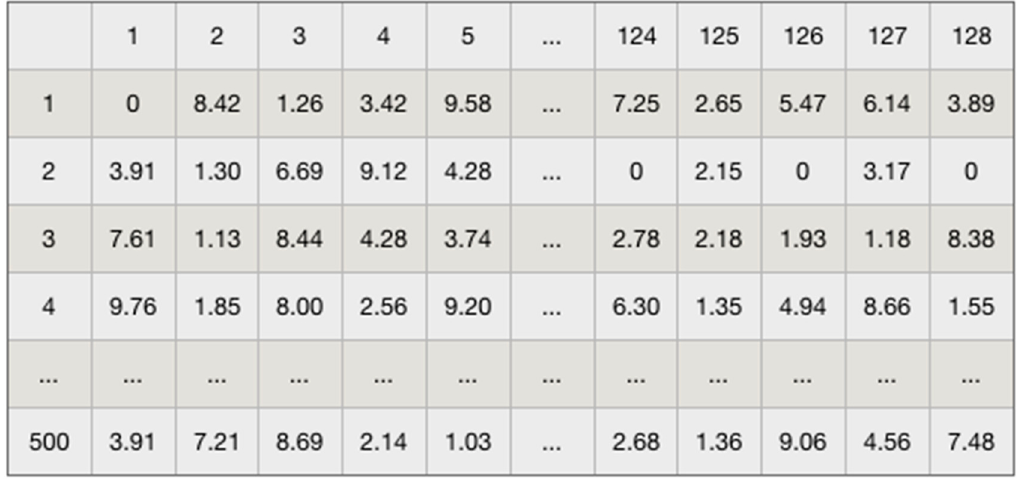
Figure 4. Keyword–RGB mapping table.